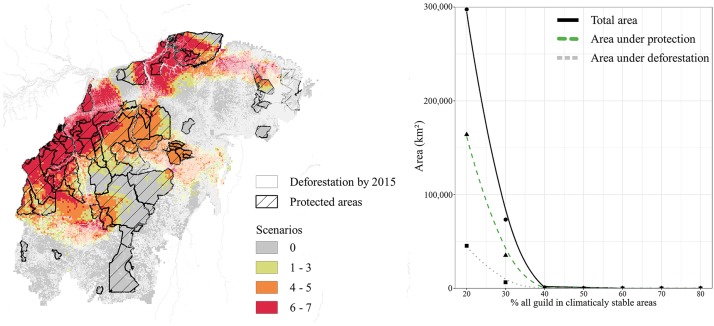
Potential climatically stable areas for conservation actions.Map indicating climatically stable suitable areas for at least 20% of each trophic guild across seven climatic scenarios. Colour scales represent the overlap of the models. All the priority areas are plotted with currently existing Protected Areas (PAs) and deforestation layers. Graphs represents the amount of climatically stable suitable areas for different percentages of a minimum guild class (solid line); the amount of area overlapped with PAs (dashed green line) and overlapped with deforested area (dotted grey line).